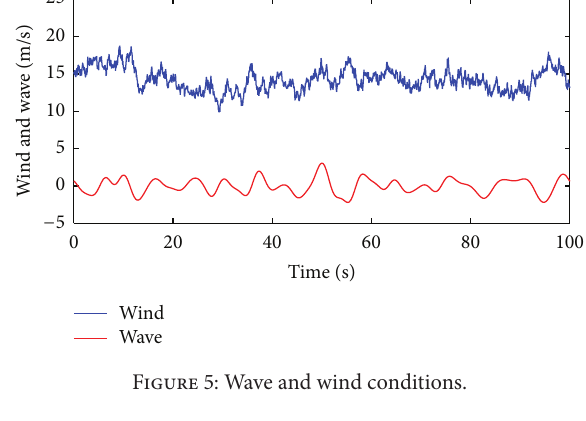
Table 4: Rule table of 𝐶 1 .